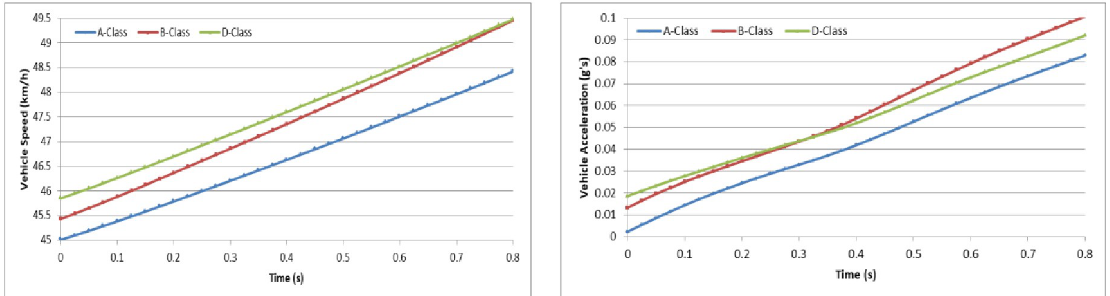
Fig 14. The changes in vehicle speed and acceleration during the reactions at initial speed = 45 km/h with different vehicle models (Group 2).